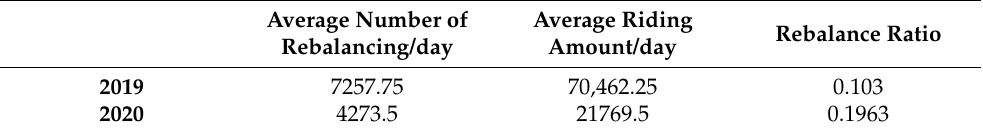
Table 4. Statistics of rebalancing times.